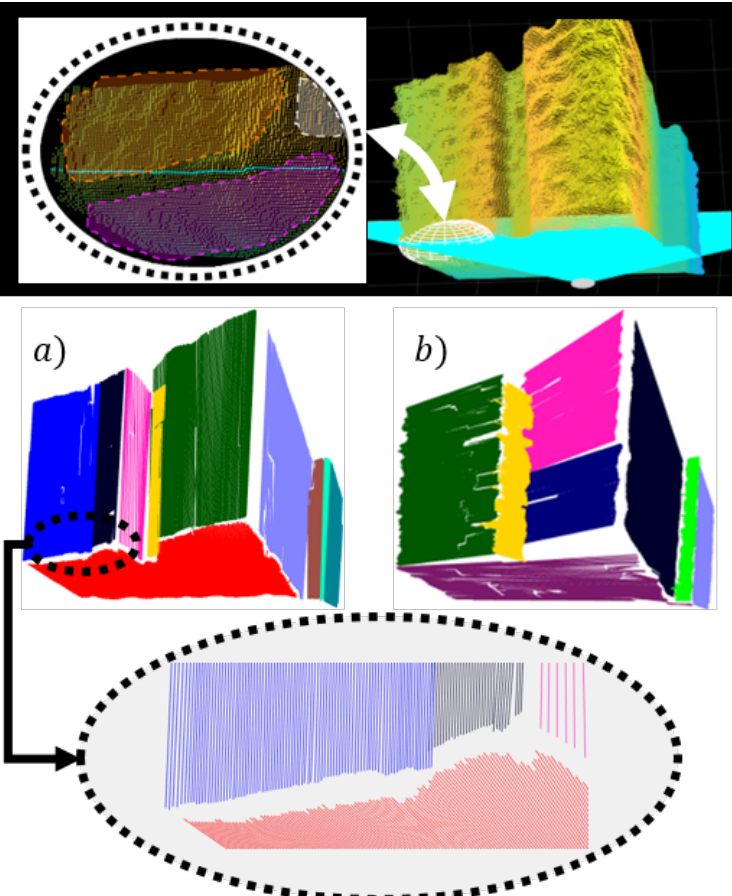
Figure 22. Horizontal scanning of a point cloud and an area of soft transitions between the boundaries of flat surfaces marked by a white ellipsoid (upper pictures). The intermediate area between colored flat surfaces represent data loss. The case of vertical clustering ( a ), for which the smallest data loss and highest accuracy is achieved. Horizontal clustering ( b ) is more affected by blurred boundaries, which caused under-segmentation of the violet colored floor and thus bigger holes.